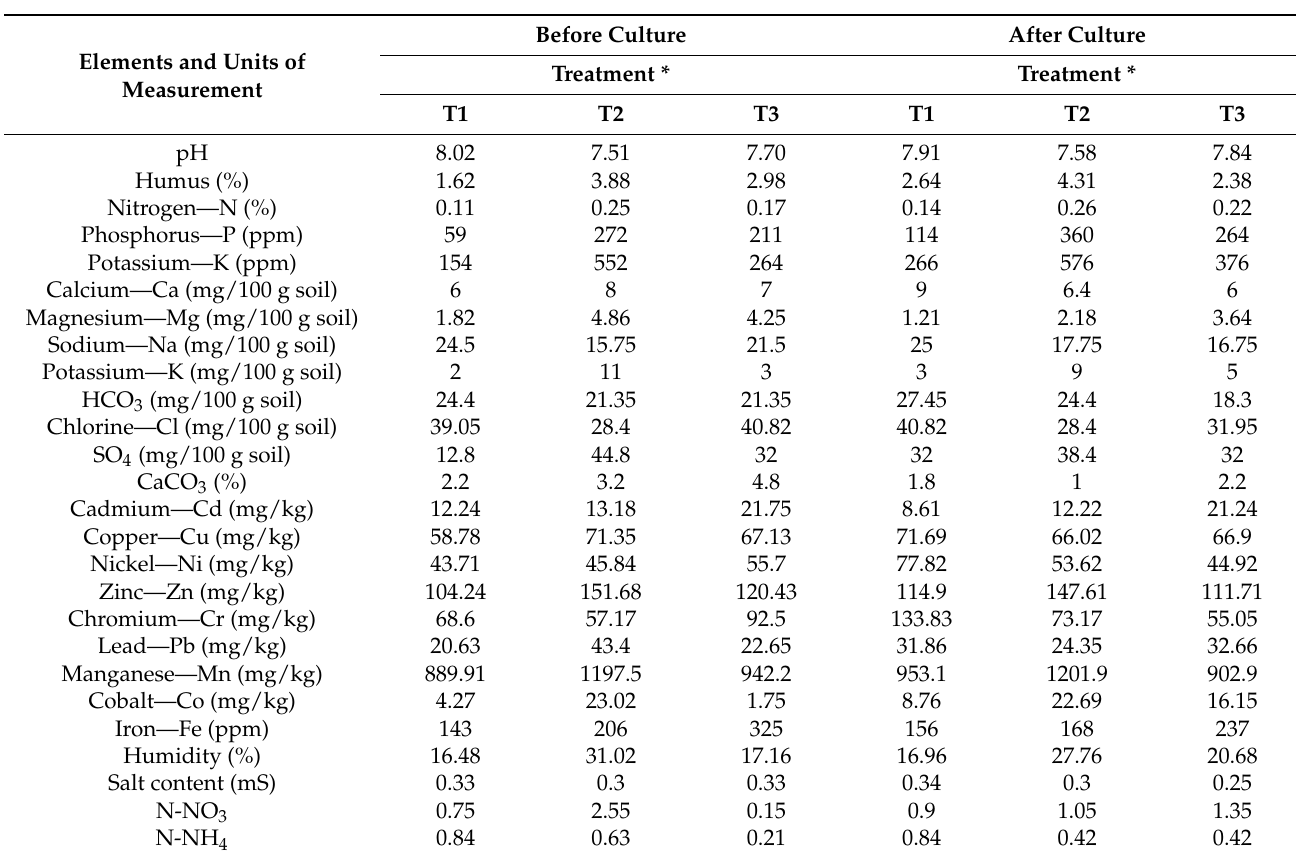
Table 1. Soil content in the main elements before transplanting the tomato seedlings in the three tunnels, where the three treatments (T1, T2 and T3) were applied and after culture (after the clearing of plants at the final